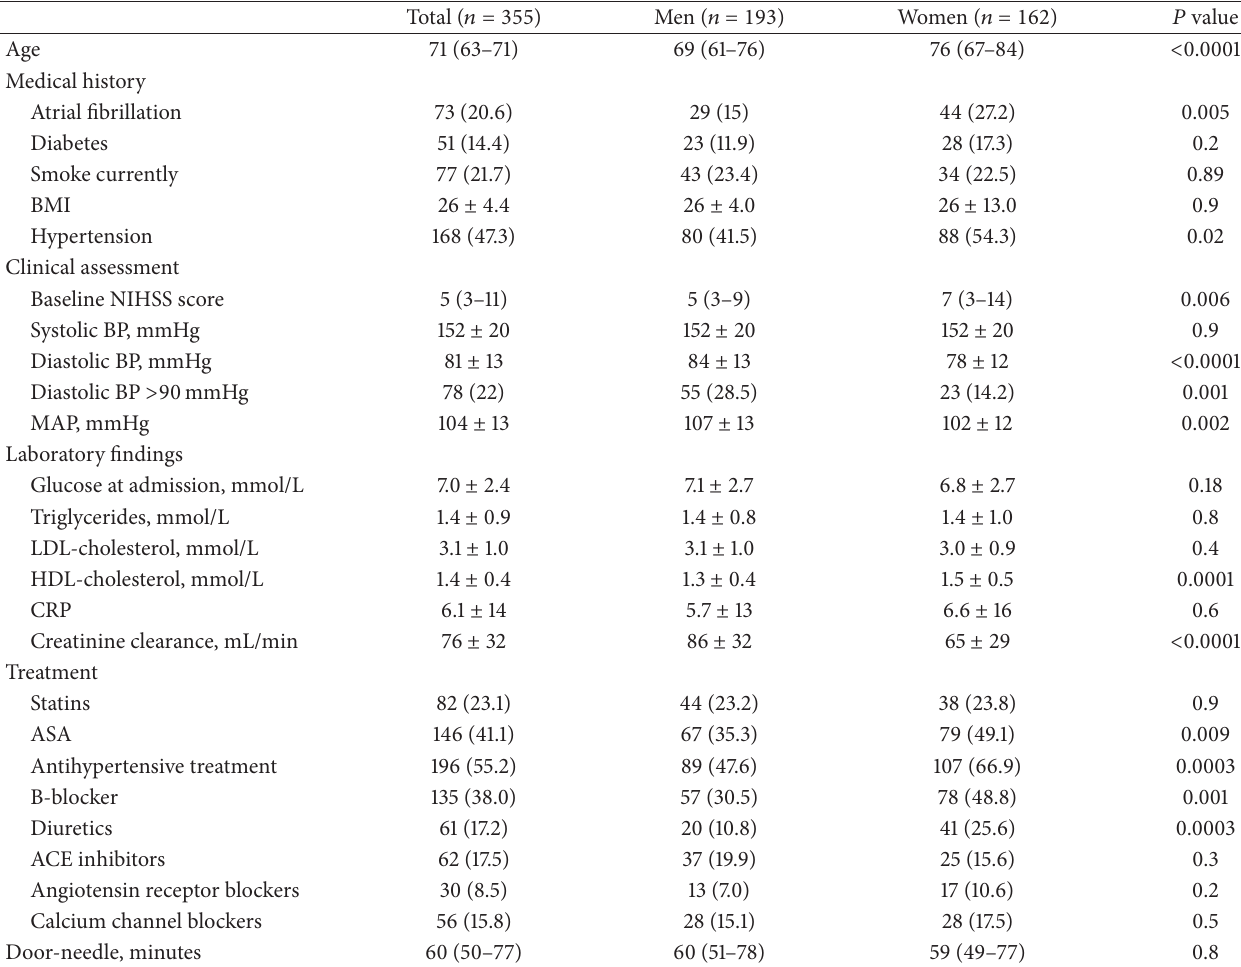
Table 1: Baseline